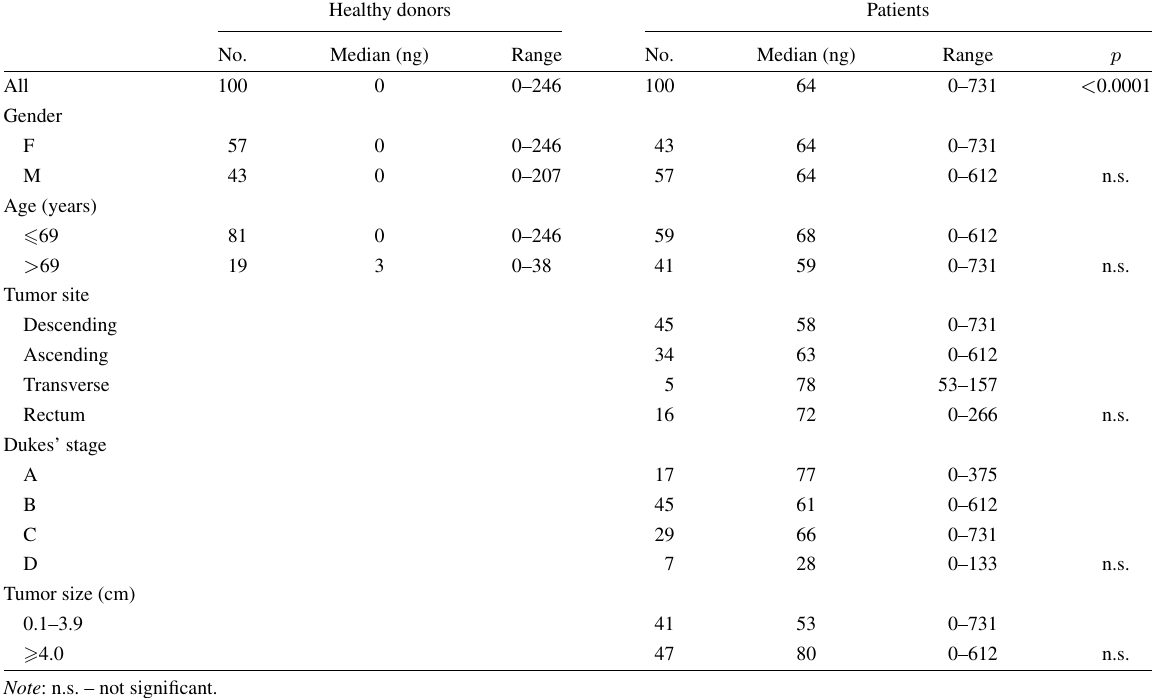
FL-DNA fecal levels as a function of clinical and pathological characteristics